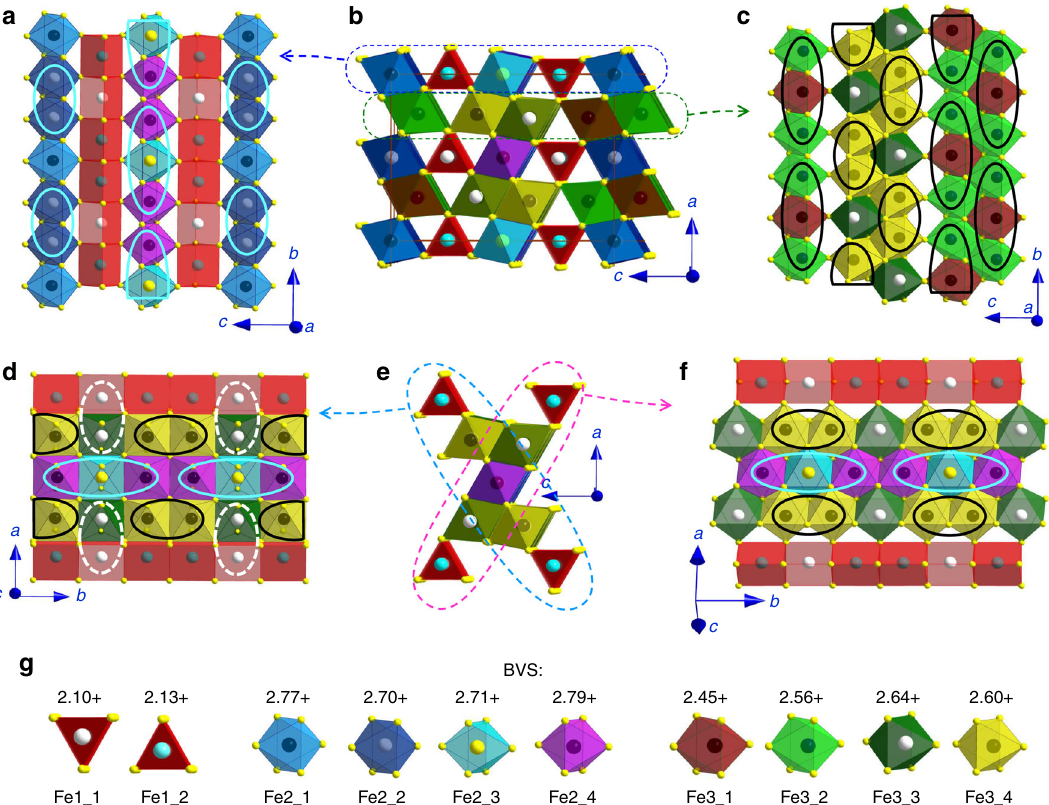
Fig. 4 Monoclinic crystal structure of Fe 4 O 5 -III-a. This structure has C 2 /m symmetry and plots are based on the crystal structure data re fi ned at 11.7 GPa and 180 K. a Projection of the trigonal prisms Fe1 and single chains of Fe2 octahedra. b The unit cell projected down the b -axis. Thin solid lines indicate the unit cell edges. c Projection of the double chains of Fe3 octahedra. d Projection down the c -axis of one of the two diagonal ribbons shown in e . e Two characteristic diagonal ribbons consisting of fi ve iron chains each. f Projection of one of two diagonal ribbons shown in e . Solid ellipsoids are dimers and trimers formed in the chains of octahedrally-coordinated iron. Dotted ellipsoids highlight Fe3 – Fe1 pairs with shortened Fe – Fe length. Different crystallographic positions are shown in different colors. g Bond valence sums (BVS) values of all the iron cations in the crystal